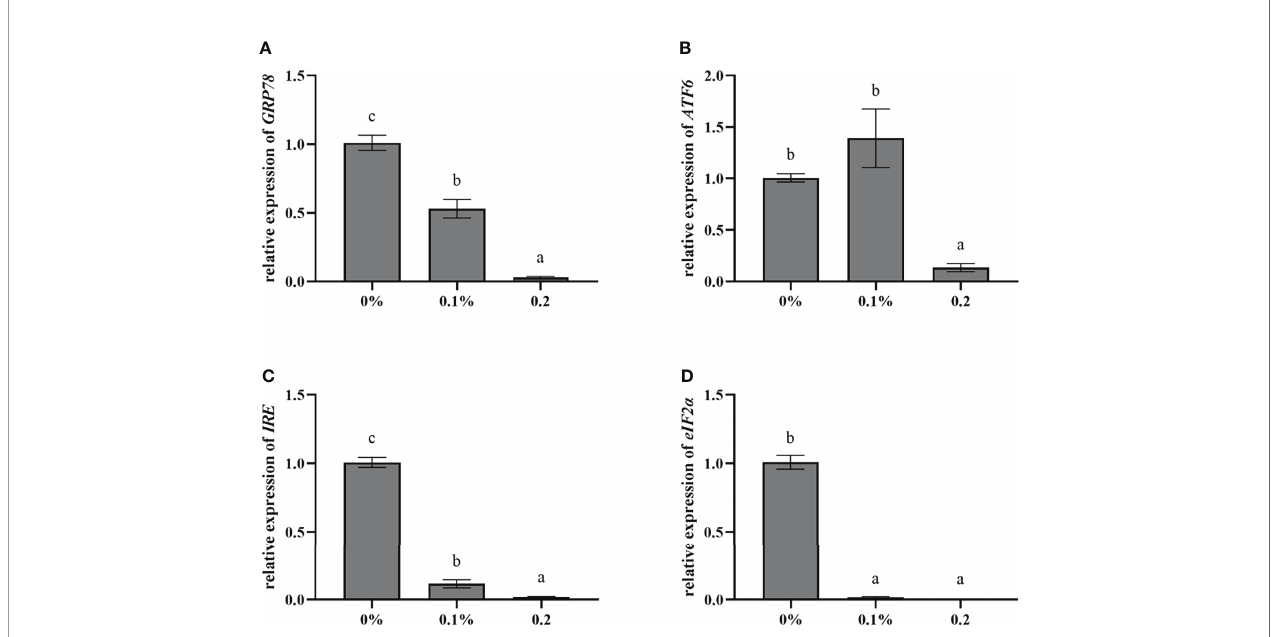
FIGURE 5 | Effect of dietary nano-curcumin on glucose-regulated protein78 ( GRP78 ) (A) , activating transcription Factor6 ( ATF6 ) (B) , inositol-requiring enzyme ( IRE ) (C) , and eukaryotic initiation factor 2 a ( eIF2 a ) (D) related gene mRNA levels in the liver of largemouth bass. Values (mean ± standard error of the mean, SEM) in bars that have the same letter are not signi fi cantly different (P > 0.05; Duncan ’ s test) between treatments (N =